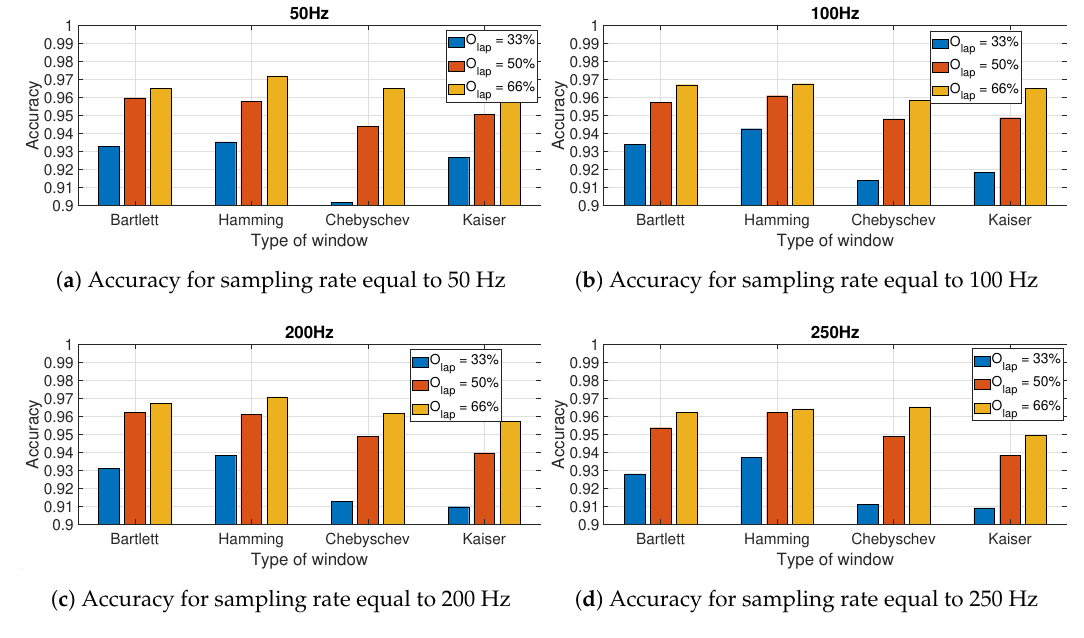
Figure 11. Accuracy for AccZ in relation to the type of window used in the spectrogram for different sampling rates and different values of the overlapping factor O lap and W R =